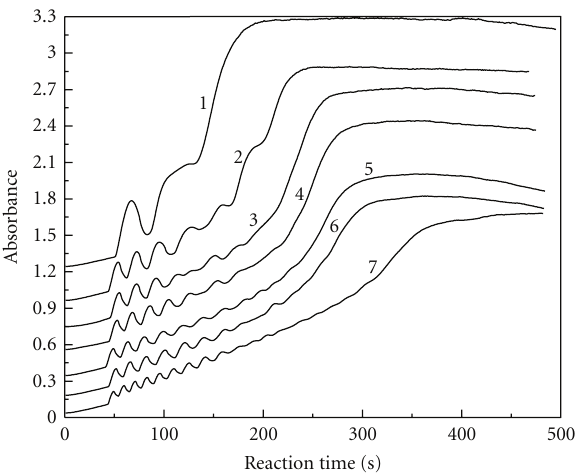
Figure 3: The absorbance versus reaction time at 289nm for the triiodide ion: [MAA] 0 = 6 . 29 × 10 − 3 mol / L, [H 2 SO 4 ] 0 = 3 . 50 × 10 − 3 mol / L, [KI] 0 = 3 . 82 × 10 − 3 mol / L, [ClO 2 ] 0 = 8 . 43 × 10 − 4 mol / L (curve 1), 8 . 52 × 10 − 4 mol / L (curve 2), 8 . 76 × 10 − 4 mol / L (curve 3), 9 . 02 × 10 − 4 mol / L (curve 4), 9 . 11 × 10 − 4 mol / L (curve 5), 9 . 26 × 10 − 4 mol / L (curve 6), 9 . 51 × 10 − 4 mol / L (curve 7).